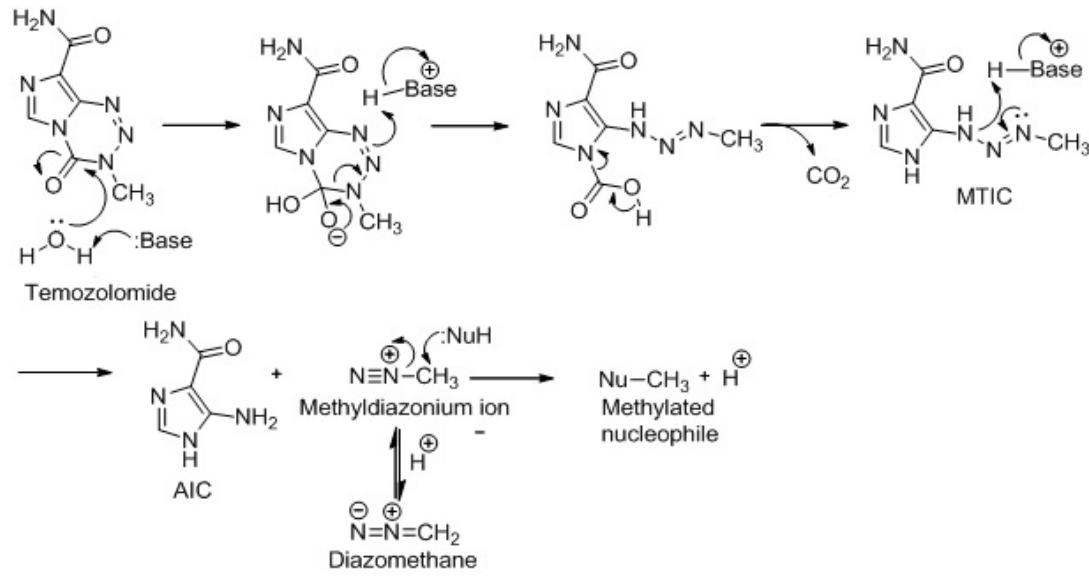
Figure 1. scheme of TMZ ring opening. methydiazoniumion Figure 1. Scheme of TMZ ring opening.